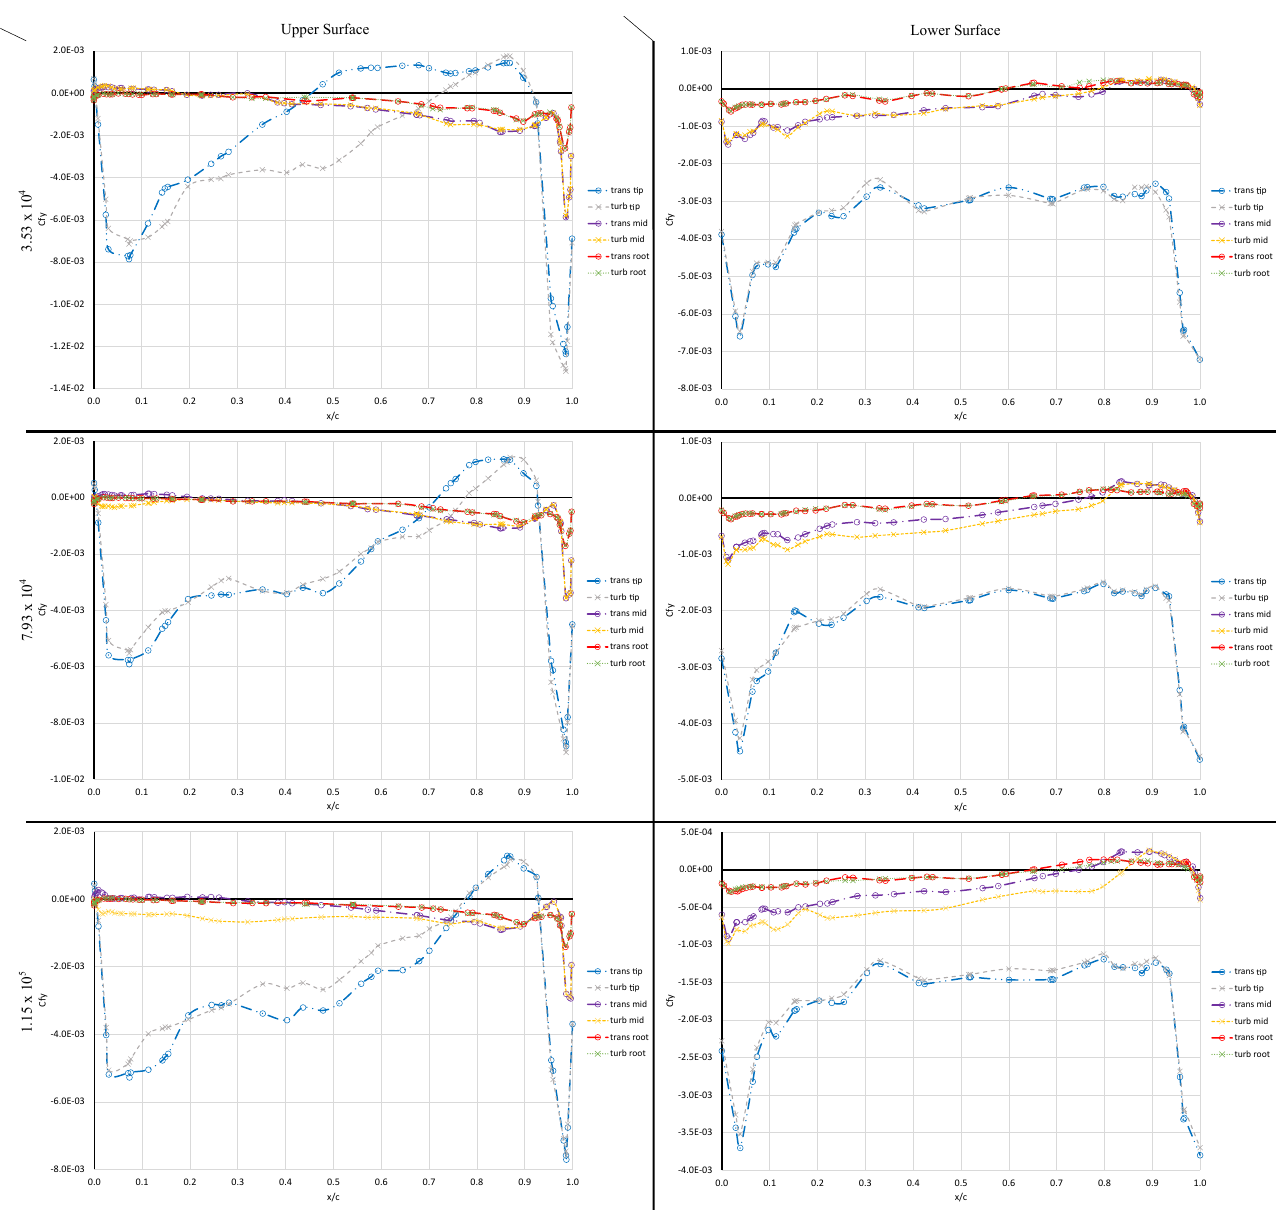
Figure 13. Skin-friction coefficient along the chord for different sections along the span. Boundary-layer separation causes losses in lift and increases the drag; therefore, the overall performance of the rotor is reduced. The separation bubble found at the tip’s leading edge is small, and then it re-attaches, but the boundary layer becomes turbulent. This separation could be promoted by the strong tip vortices developed by these rotors. From the mid-span to the root, the boundary layer separates close to the trailing edge, but it does not re-attach. Argus et al. [8] suggested that reduction of the separation zones and an early transition to a turbulent boundary layer lead to gains in rotor performance. However, the experimental study of Jaroslawski et al. [20] demonstrated that forcing the transition from laminar to turbulent with roughness leads to a significant reduction in the hover rotor efficiency. Therefore, the redesign of the tip and mid-span zones could lead to improvements in the rotor’s performance. Through computational simulations, it is possible to estimate the sizes of the separation bubbles; however, for rotors operating at low to medium Reynolds numbers, a transition-turbulence model could lead to better results, thereby improving rotor